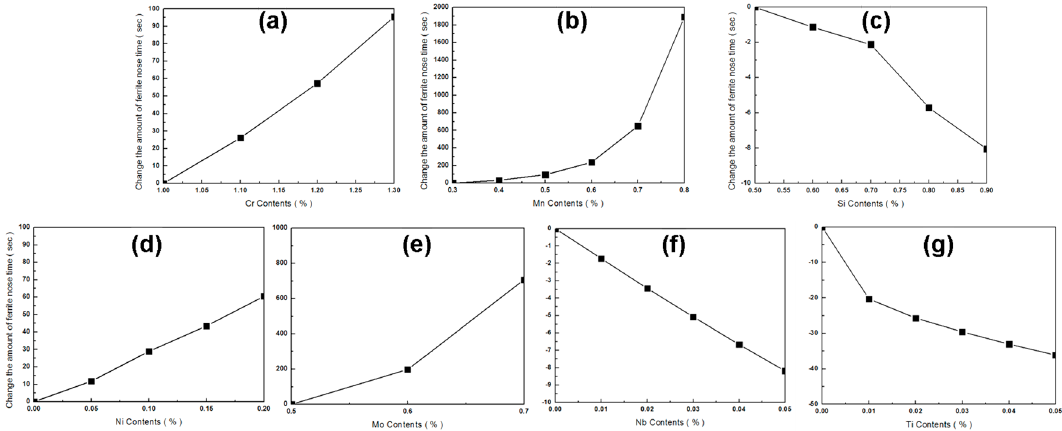
Figure 5. Effects of alloying element additions on the ferrite nose time of the alloys, simulated using